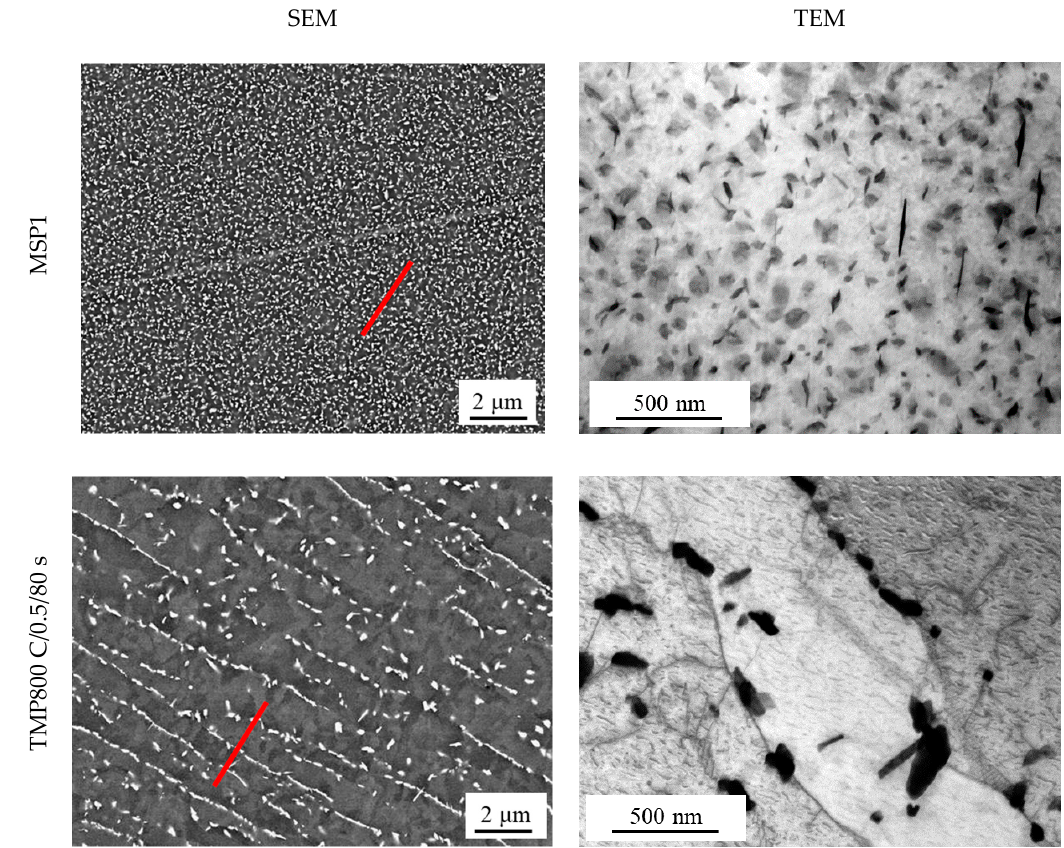
Figure 6. SEM (left, arrows indicate plane of TEM view)/TEM (right) micrographs: intragranular precipitate morphology (IG c ) of MSP1 (top) and TMP800C/0.5/80s (bottom)